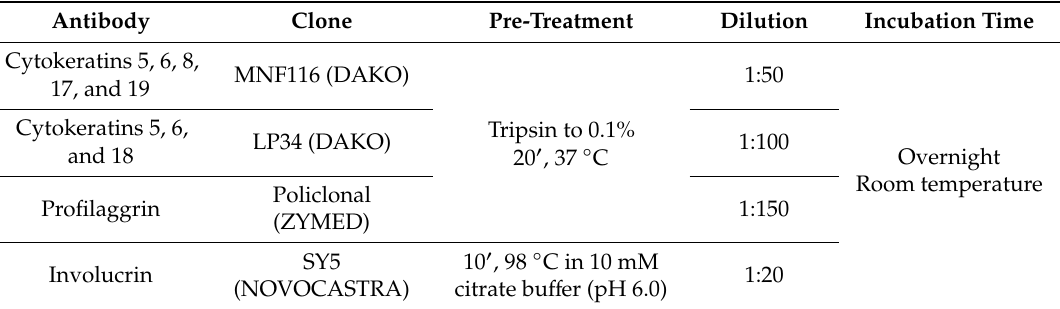
Table 2. Antibodies and